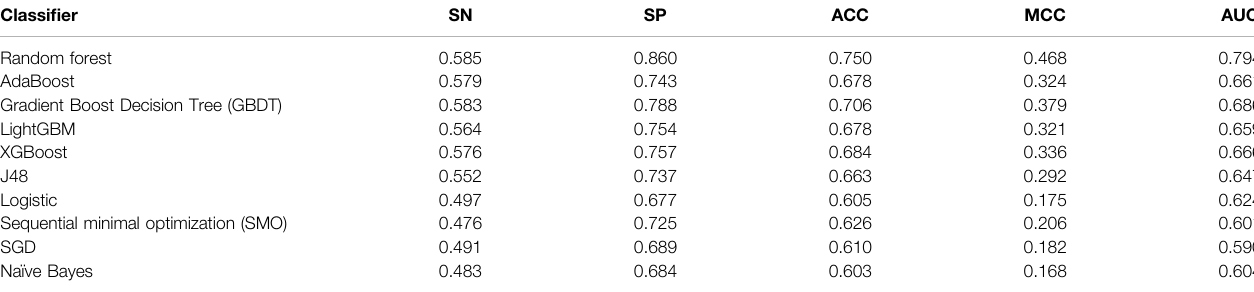
TABLE 4 | Performance of various classi fi ers utilizing AAC-DDE-GDC-gap1 feature and fi vefold cross-validation on the training dataset. Classi fi er SN SP Random forest